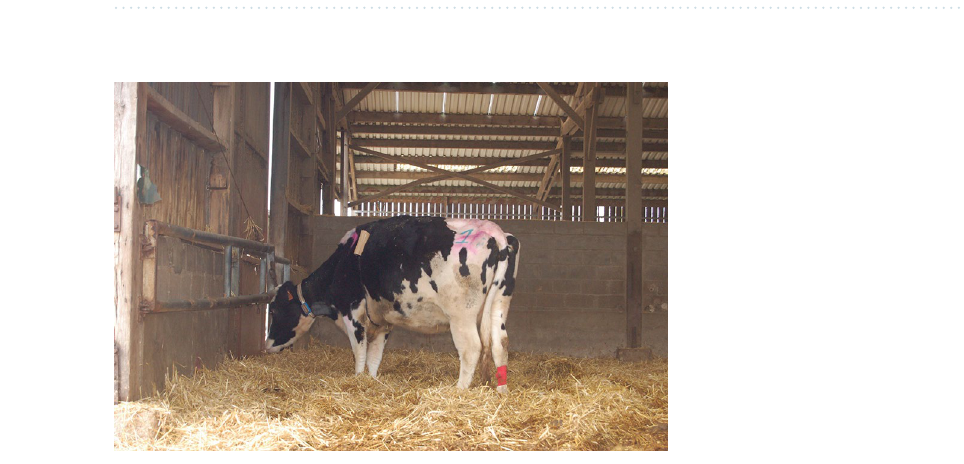
Table 1. Description of the behaviour patterns detected by direct behavioural observations in the barn.